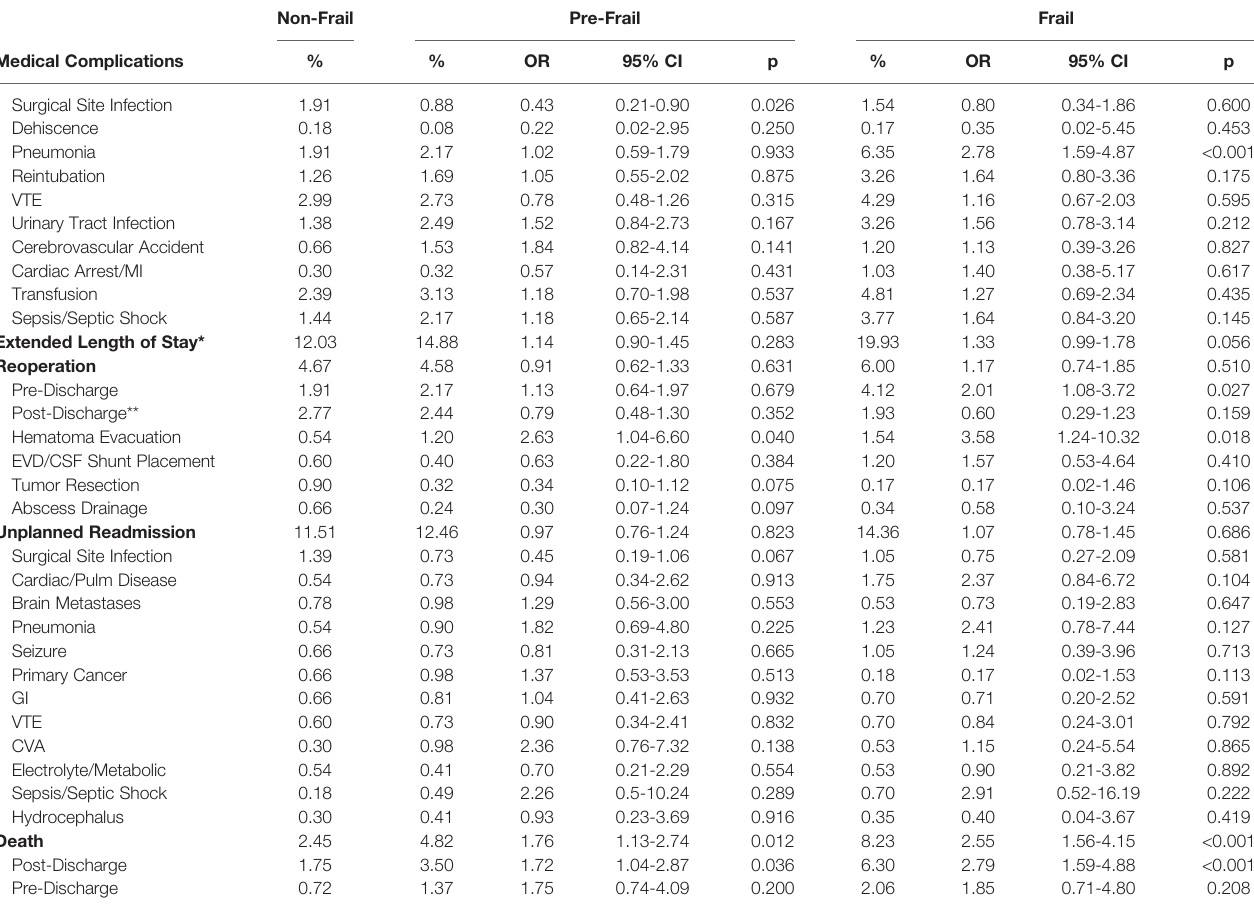
TABLE 4 | Adjusted association of pre-frailty and frailty with 30-day postoperative complications compared with non-frail patients. Non-Frail Pre-Frail Frail Medical Complications Surgical Site Infection